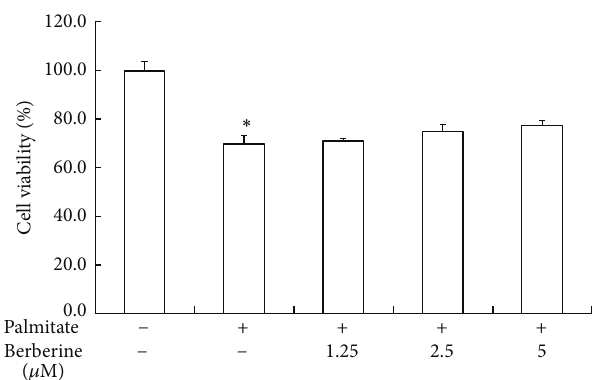
Figure 1: The effects of berberine on viability of HUVECs exposed to palmitate. HUVECs were cultured in RPMI-1640 containing 0.5 mmol/L palmitate and treated with 1.25, 2.5, and 5 𝜇 mol/L berberine for 24 h. Cell viability was measured by MTT assay and normalized to cells incubated in control medium. Data were expressed as mean ± S.E.M. ∗ 𝑃 < 0.05 versus control.